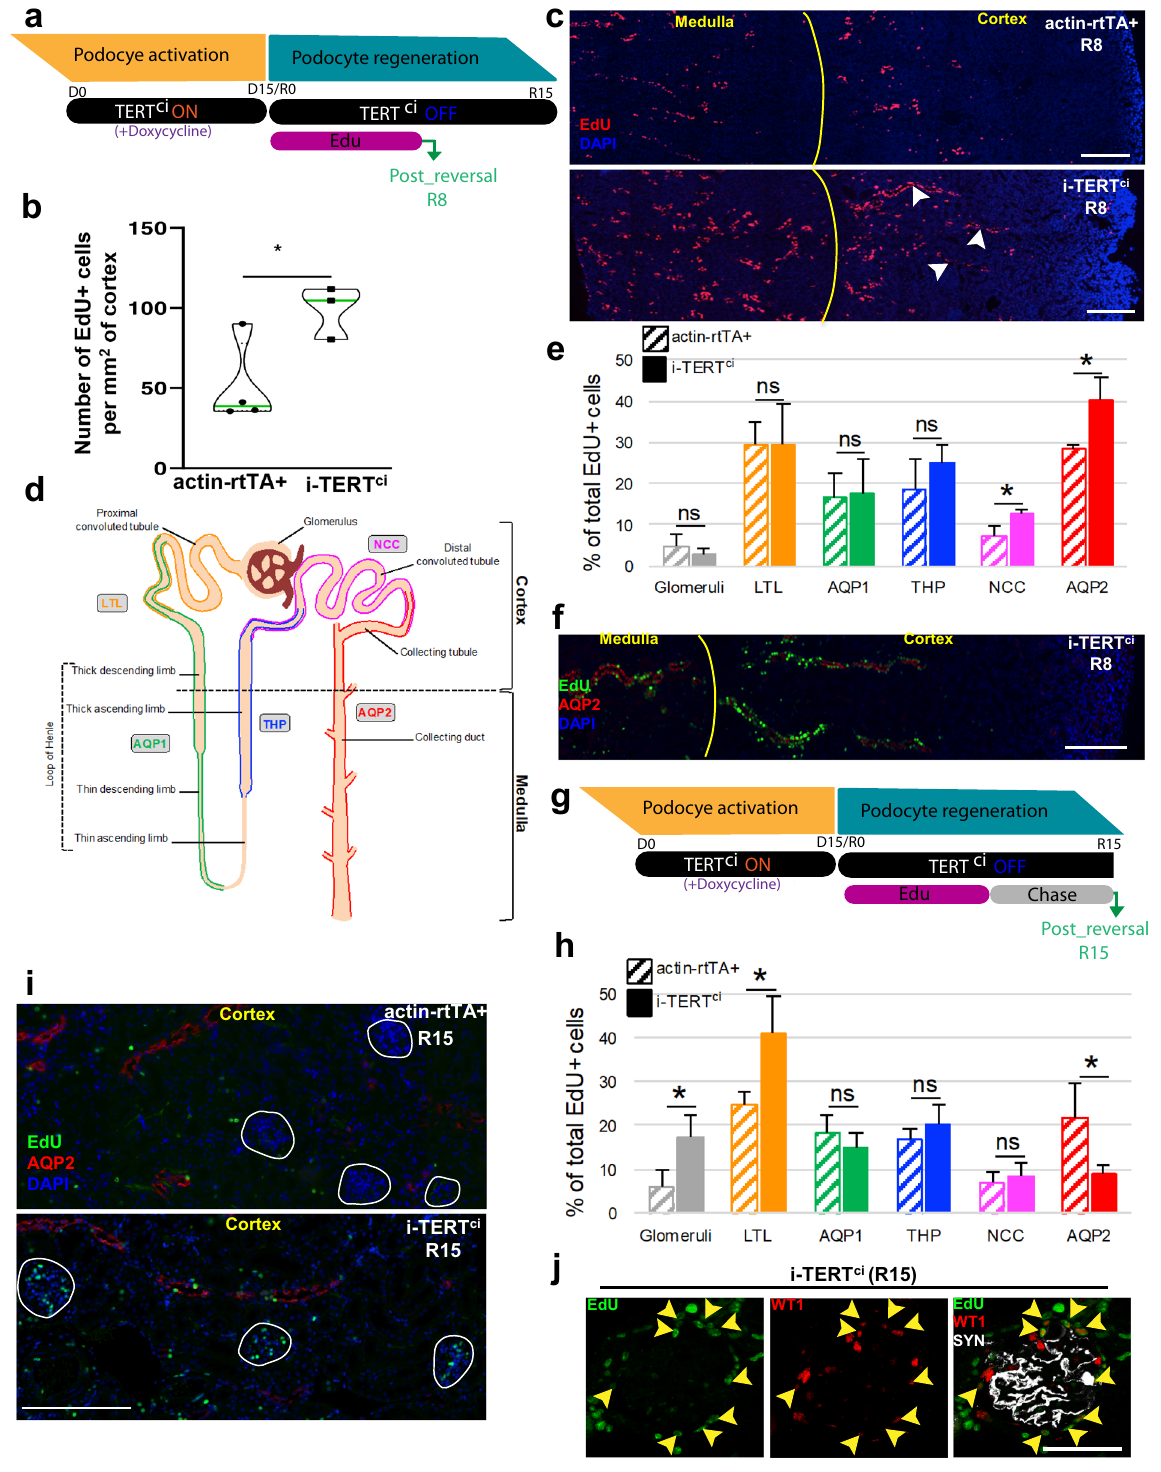
(Fig. 5f). Immunostaining for the nuclear podocyte differentiation marker WT1 on semi-thick kidney sections from a UBC CreERt2 ; R26 Confetti ;i-TERT ci mouse with GFP + clonal glomeruli revealed that 29.4% (± 3.9%) of the GFP + cells displayed podocyte differentiation marker (Fig. 5g). This result suggests that a considerable proportion of the newly generated clonal cells are